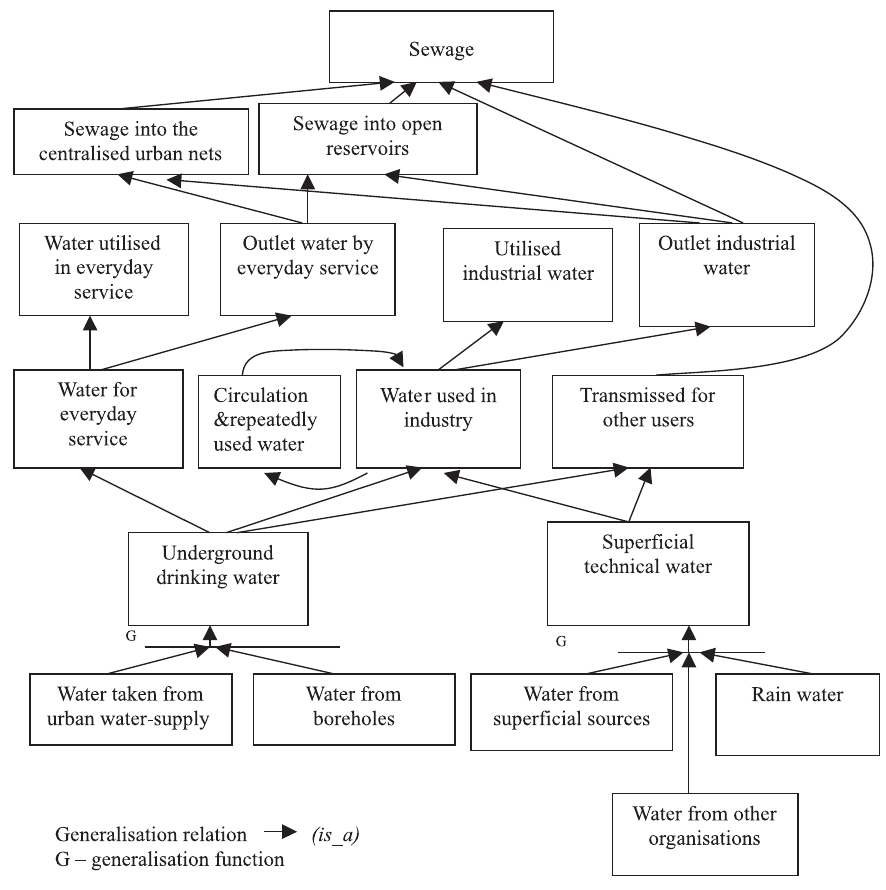
Fig. 3. An example of semantic representation of water distribution in a contamination